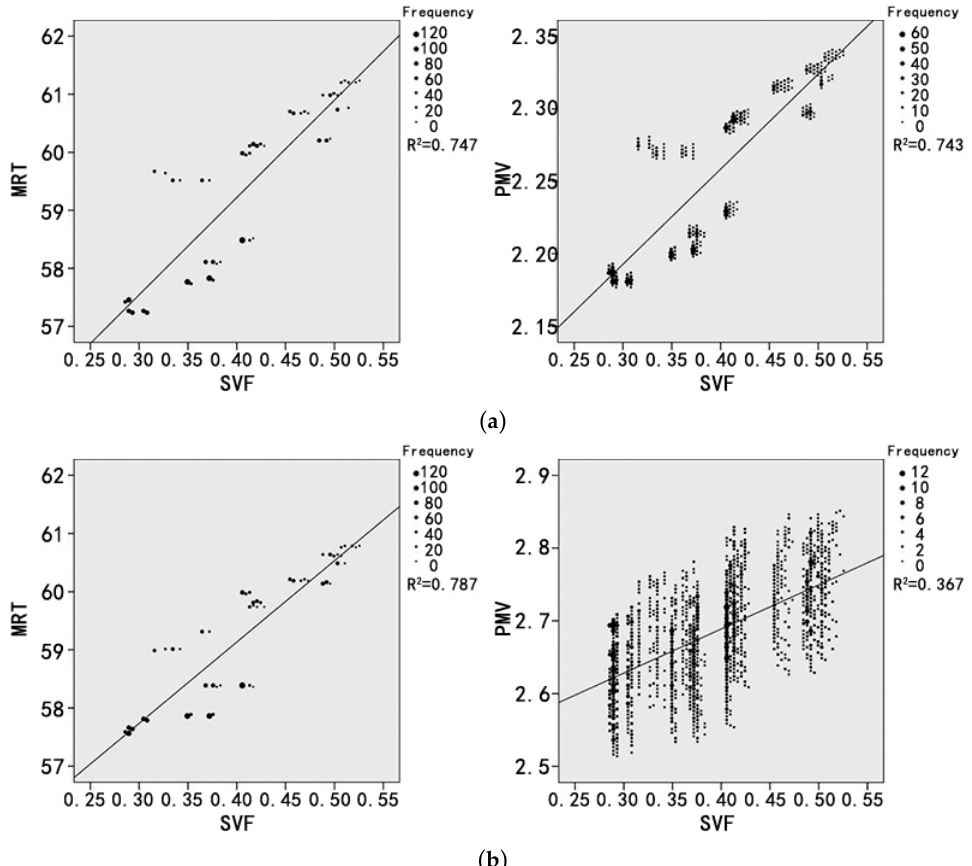
Figure 7. Correlation between SVF and MRT/PMV of the model LCZ3 at 12:00 with ( a ) WS = 0.5 m/s and ( b ) WS = 3 m/s.